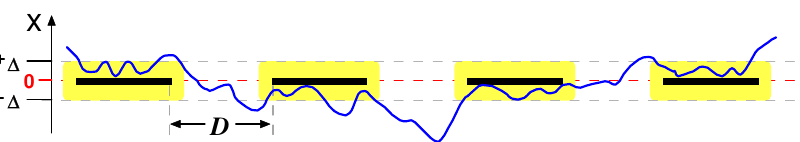
Figure 5. A wormlike chain near a porous solid nanofilm of effective thickness 2 ∆ . The chain can freely pass from one side of the film to the other through the holes of diameter ∼ D